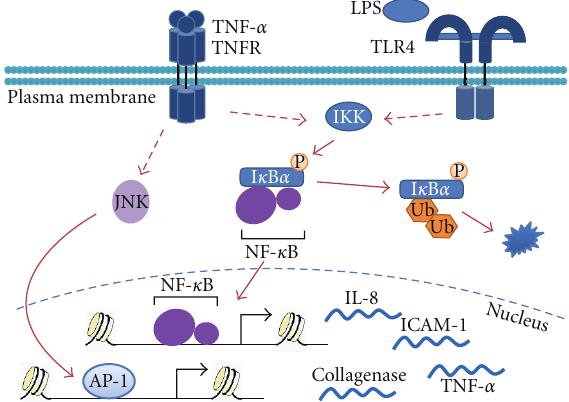
Figure 1: Transcriptionalcontrol of inflammation.Signaltransduc- tion of proinflammatory cytokines, for example, TNF- α and/or LPS signalslead to activation of IKK complex to liberate cytosolic NF- κ B from inhibition via ubiquitination and degradation of I κ B α. These stimuli activate the JNK-AP-1 pathway. Coordinated actions of NF- κ B and AP-1 propagate inflammation via promoting transcription of cytokines, chemokines, and other proinflammatory